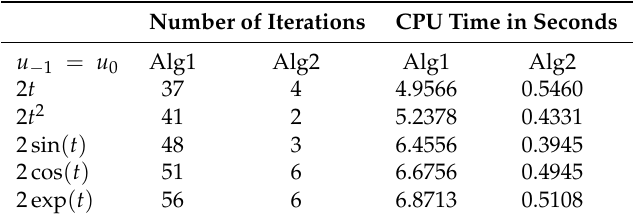
Table 5. Example 3: Algorithm 1’s numerical comparison with Algorithm 1 in